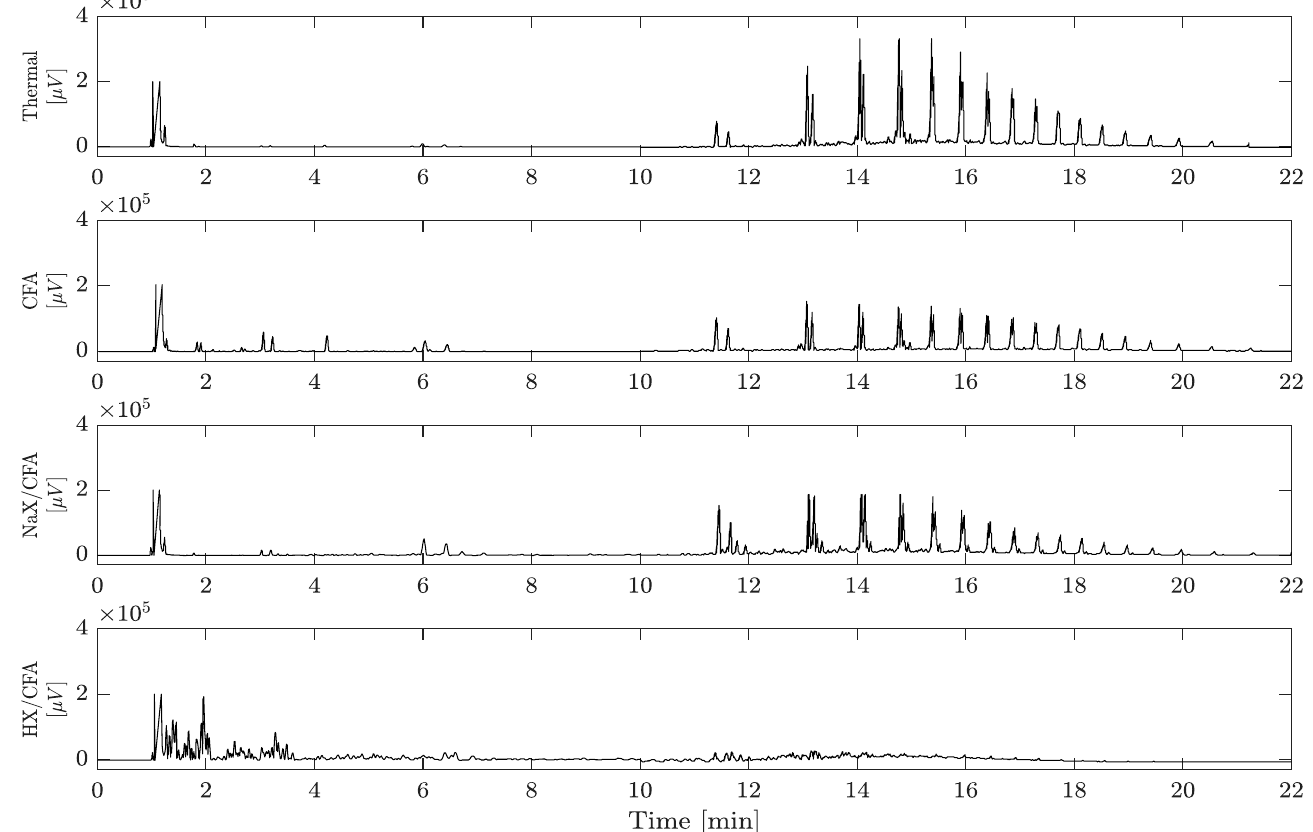
Figure 2. Gas chromatogram of oils produced from thermal and catalyzed pyrolysis (CFA, NaX/CFA, and HX/CFA).